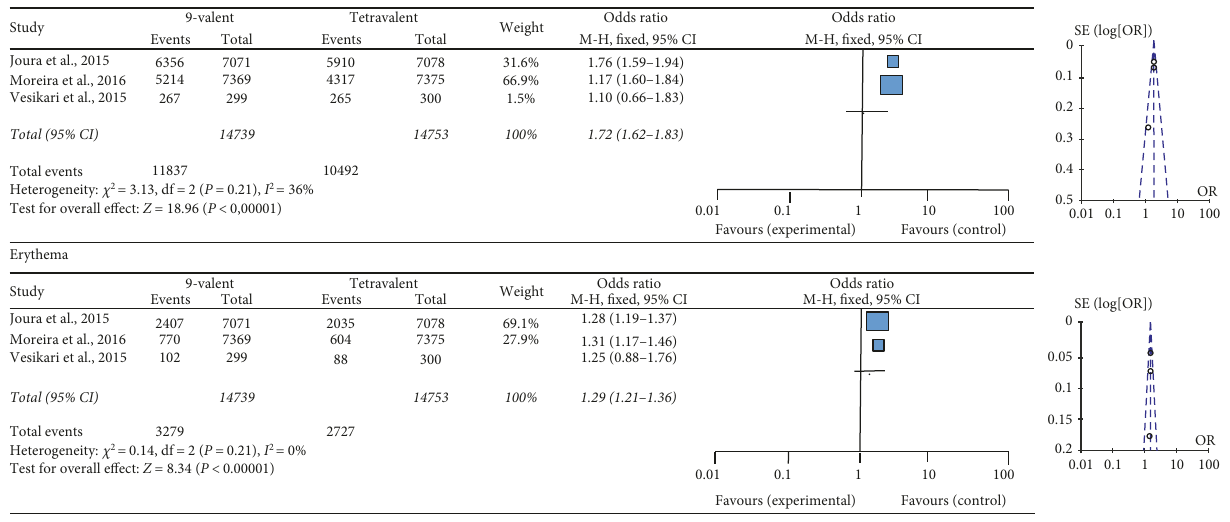
Figure 3: Forest and funnel plots of injection site-related adverse e ff